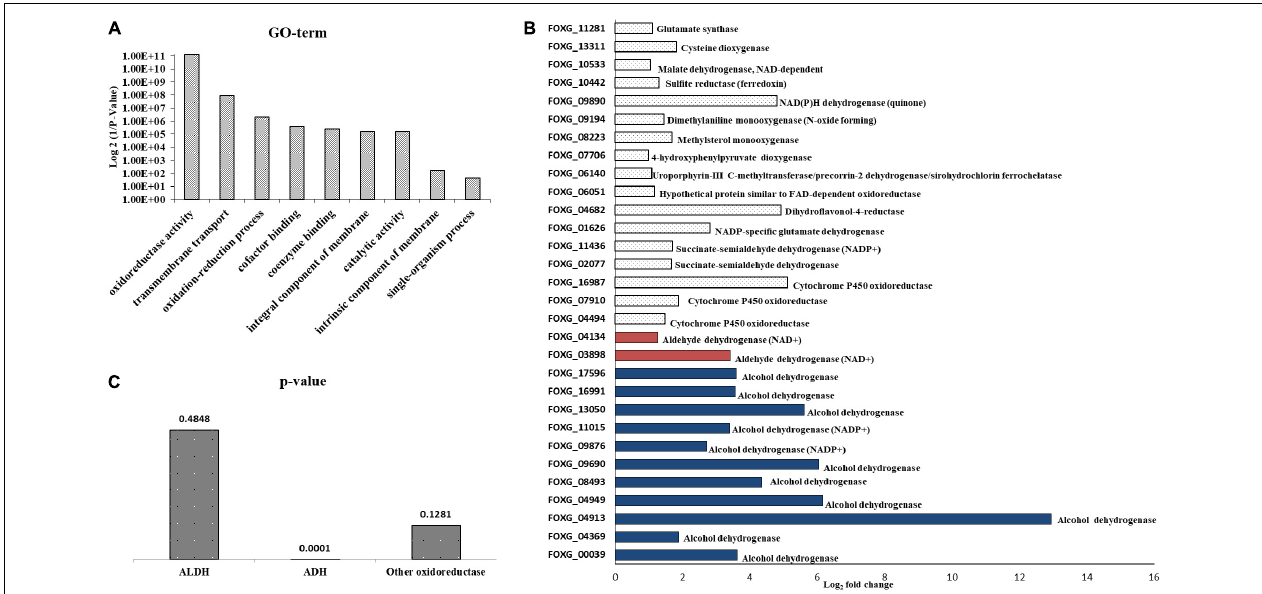
FIGURE 3 | RNA sequencing of conidia exposed to NA revealed upregulation of oxidoreductases. (A) GO-term analysis of differentially upregulated genes following NA exposure. (B) Alcohol dehydrogenases are the major oxidoreductases to be upregulated as compared to other oxidoreductases. Upregulation of all genes presented is statistically significant with p < 0.05 as predicted by Chi-square t -test. (C) p -value graph of oxidoreductases among all the upregulated genes (annotated and hypothetical). Alcohol dehydrogenases are most significantly upregulated when conidia were treated with 10 mM NA. ALDH, aldehyde dehydrogenases; ADH, alcohol